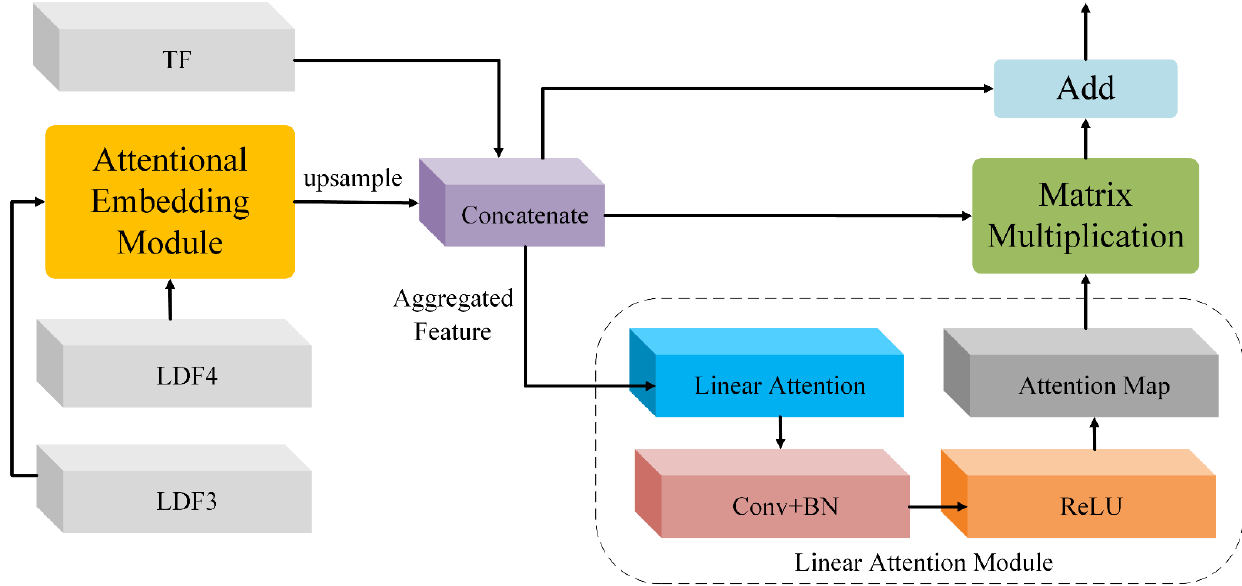
Figure 4. The feature aggregation module.